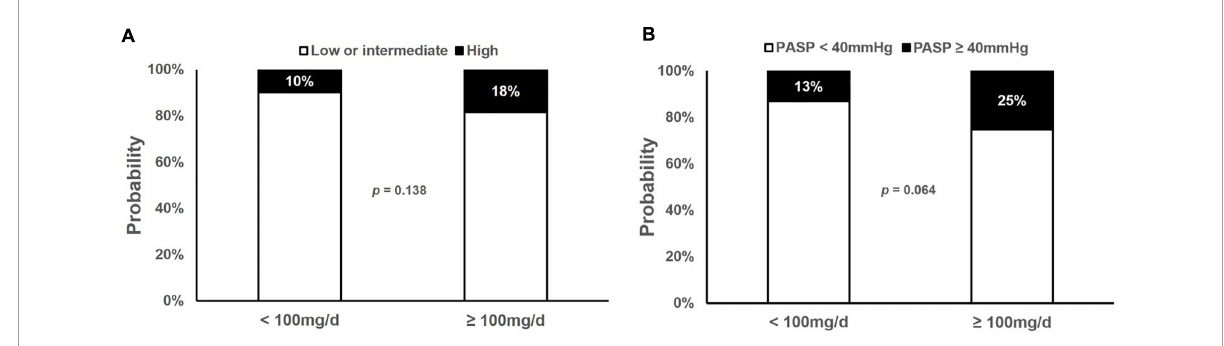
FIGURE1 Prevalence of high probability of PH and PASP ≥ 40 mmHg. Prevalence of high probability of pulmonary hypertension (PH) and pulmonary artery systolic pressure (PASP) ≥ 40 mmHg in subjects receiving current dose < 100 mg/d and ≥ 100 mg/d dasatinib showed no significant difference. (A) Prevalence of high probability of PH in cross-sectional cohort. (B) Prevalence of PASP ≥ 40mmHg in cross-sectional cohort.